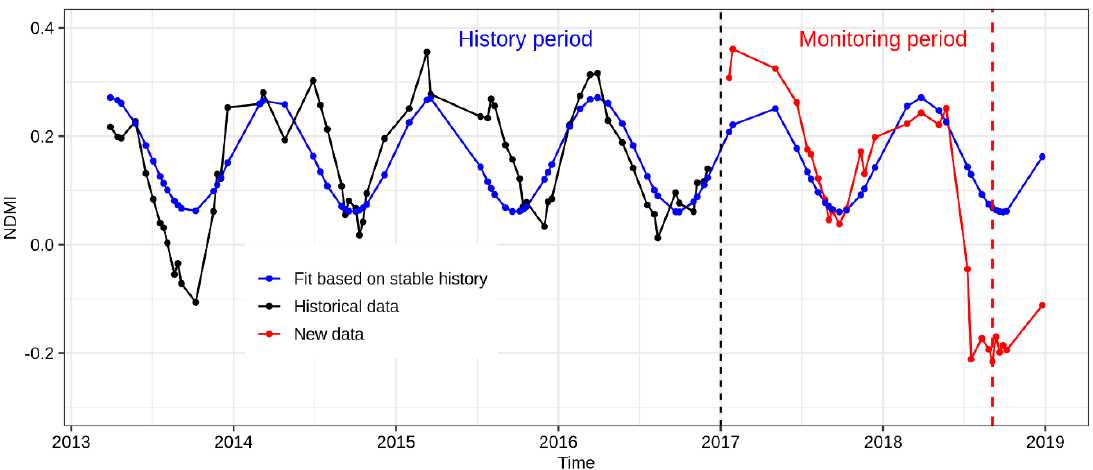
Figure 1. An example of how Breaks For Additive Season and Trend monitor (BFASTmonitor) uses historical data in the time series to identify abnormal changes in the monitoring period. Regression models estimated from the historical observations are used to predict the values of the new observations in the monitoring period. An abnormal change is signalled if the new observations are statistically different from the predicted values and the magnitude of change is negative. The vertical black dashed line represents the start of the monitoring period, whereas the vertical red dashed line indicates an abnormal change detected by BFASTmonitor. (BFAST package [14]). Here the observations are for normalised difference moisture index (NDMI) derived from Tier 1 Landsat-7/ETM+ and Landsat-8/OLI surface reflectance products.